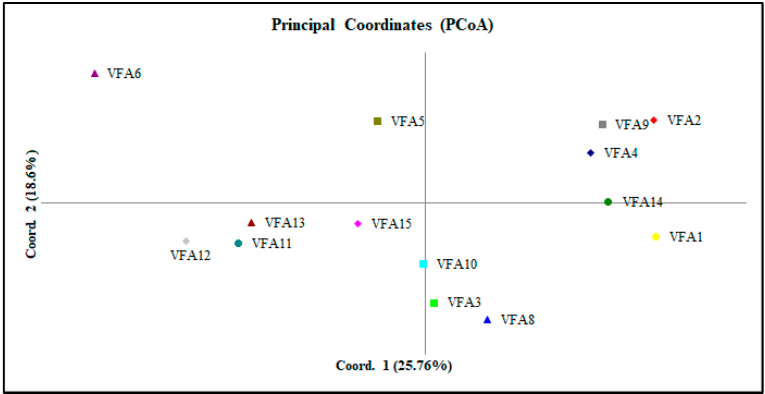
Figure 4. Principal coordinate analysis (PCoA) based on seven SSR data points of the 14 Algerian faba bean accessions. faba bean